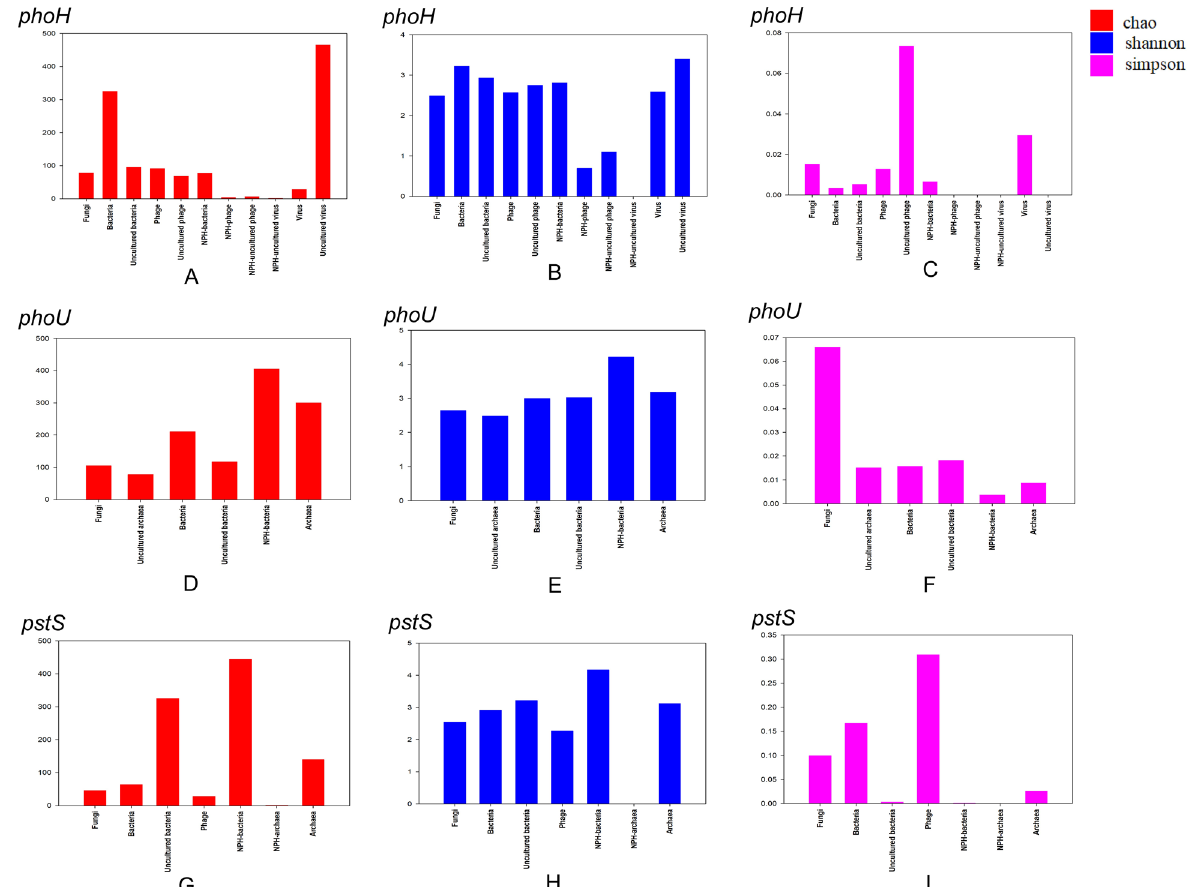
Figure 5. Plots of genetic diversity indices analysis of phosphorus metabolism AMGs from different host origins, different colors represent different genetic diversity indices. ( A, D, G ) Represent respectively the Chao values of phoH , phoU , and pstS genes from different host origins. ( B , E , H ) Represent respectively the Shannon values of phoH , phoU , and pstS genes from different host origins. ( C , F , I ) Represent respectively the Simpson values of phoH , phoU , and pstS genes from different host